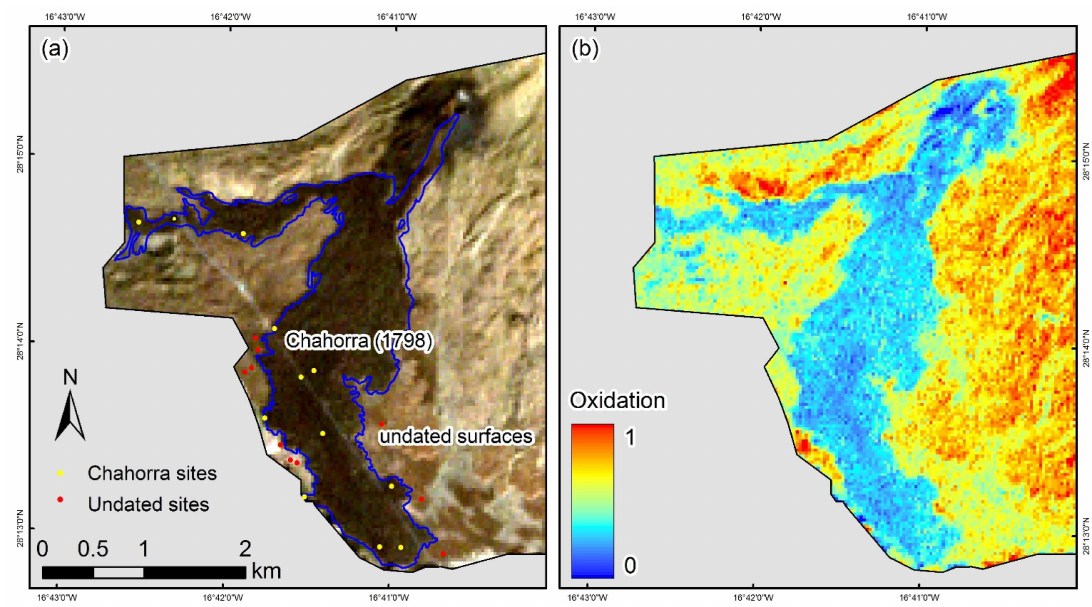
Figure 11. ( a ) Chahorra lava flow (1798) shown on the Landsat ETM+ image displayed in true color (R:G:B = b3:b2:b1); ( b ) Oxidation mapped from the Landsat ETM+ image using the relationship between oxidized surface and oxidation index shown in Figure 7c, calibrated based on the relationship between ETM+ and field spectra derived indices shown in Figure 10. The Chahorra lava flow is discriminated from its surrounding undated lava surfaces due to the contrast in oxidation level. Areas affected by steep topographic terrains and variable slope orientations are masked out (shown in grey) in the figure.